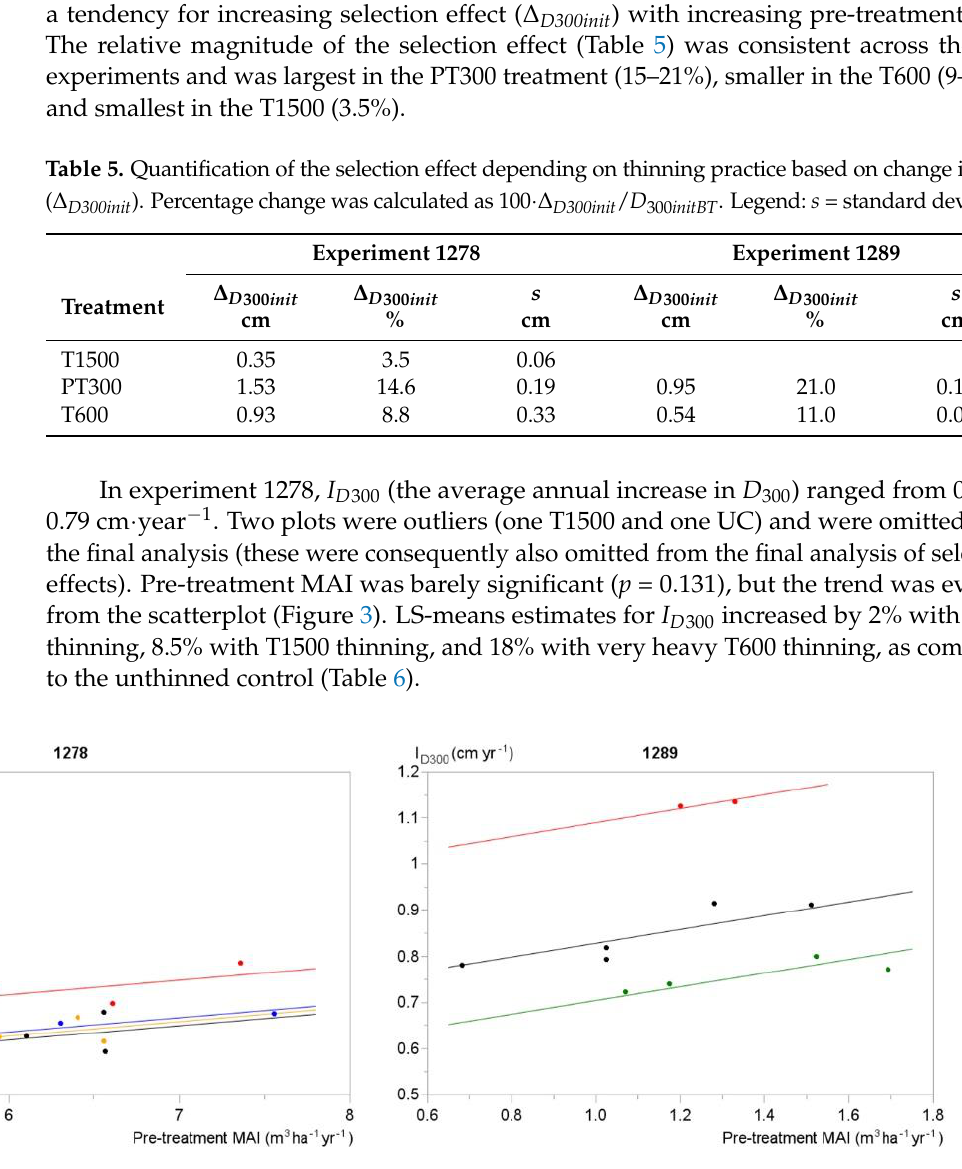
Figure 3. Mean annual change in D 300 ( I D 300 , cm · year − 1 ) vs. pre-treatment MAI ( MAI pre-trt , m 3 ha − 1 year − 1 ) depending on treatment. Parameter estimates are given in Table 6. The regression lines for 1278 were not significant ( p = 0.131) and are shown only for orientation. Legend for treatments: UC = black, UC-pruned = green, PT300 = yellow, T1500 = blue, T600 = red. In experiment 1289, I D 300 ranged from 0.72 to 1.13 cm∙year -1 . According to the final model, I D 300 increased with pre-treatment MAI and depended on thinning treatment (Fig- ure 3). Comparing unthinned plots with or without the pruning of 300 trees per ha, LS- means estimates indicated a reduction in I D 300 by 14% due to pruning (Table 6). Comparing unthinned plots and the heavily thinned T600 plots, in both cases without pruning of any trees, T600 thinning resulted in an increase in I D 300 by 30%. Table 6. Parameter and LS-means estimates for the final model of mean annual change in D 300 ( I D 300 ) depending on treatment and pre-treatment MAI. Legend: n = number of observations, R 2 = coefficient of determination. Variable/ Treatment